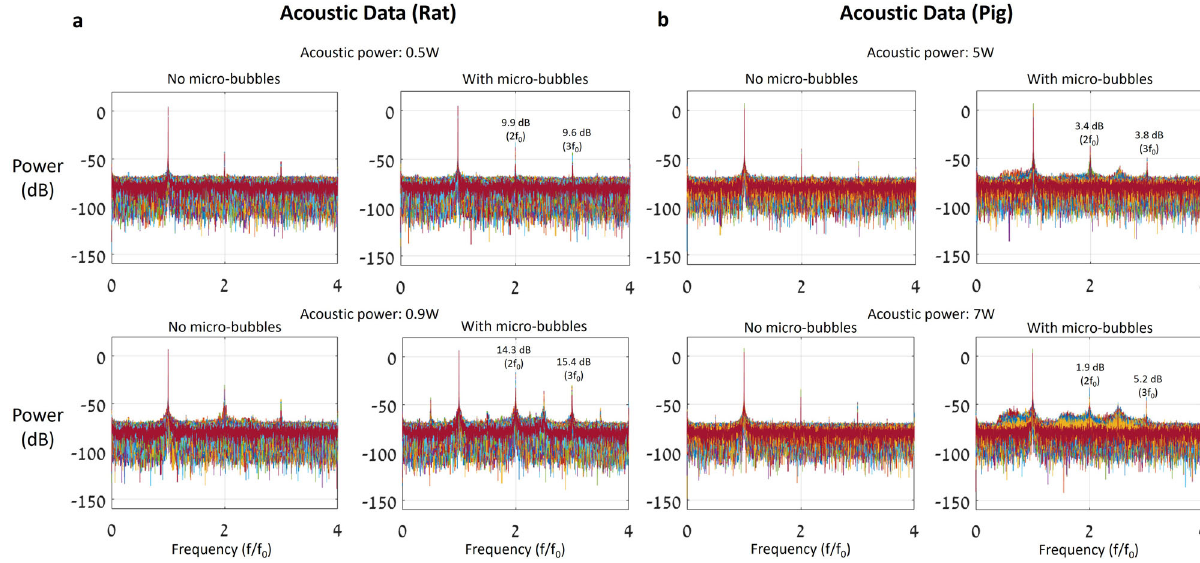
Fig. 6 Pig and rat power spectrum data comparison. Power spectrums of a rat and a pig, in two acoustic powers: 0.5 and 0.9 W for rat ( a ) and 5 and 7 W for pig ( b ). Each fi gure in a contains power spectrums of 490 pulses and each fi gure in b contains power spectrum of 144 pulses. The numbers in the “ With microbubbles ” fi gures show the second and third harmonic power changes compared with the baseline ( “ No microbubbles); the harmonic power changes in the pig were much lower despite the higher acoustic